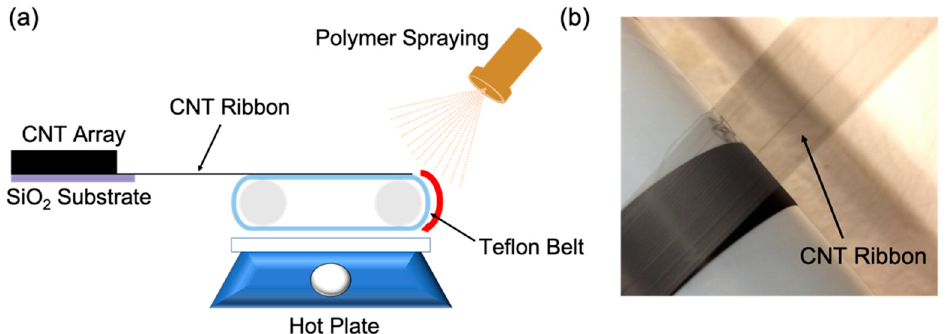
Figure 1. Illustration of the CNT-NEE fabrication process. ( a ) Ribbon-like CNTs drawn by a moving belt onto a Teflon substrate, where liquid HNBR is sprayed onto the CNT ribbon. ( b ) Photograph of the ribbon-like CNTs employed for CNT-NEE fabrication.